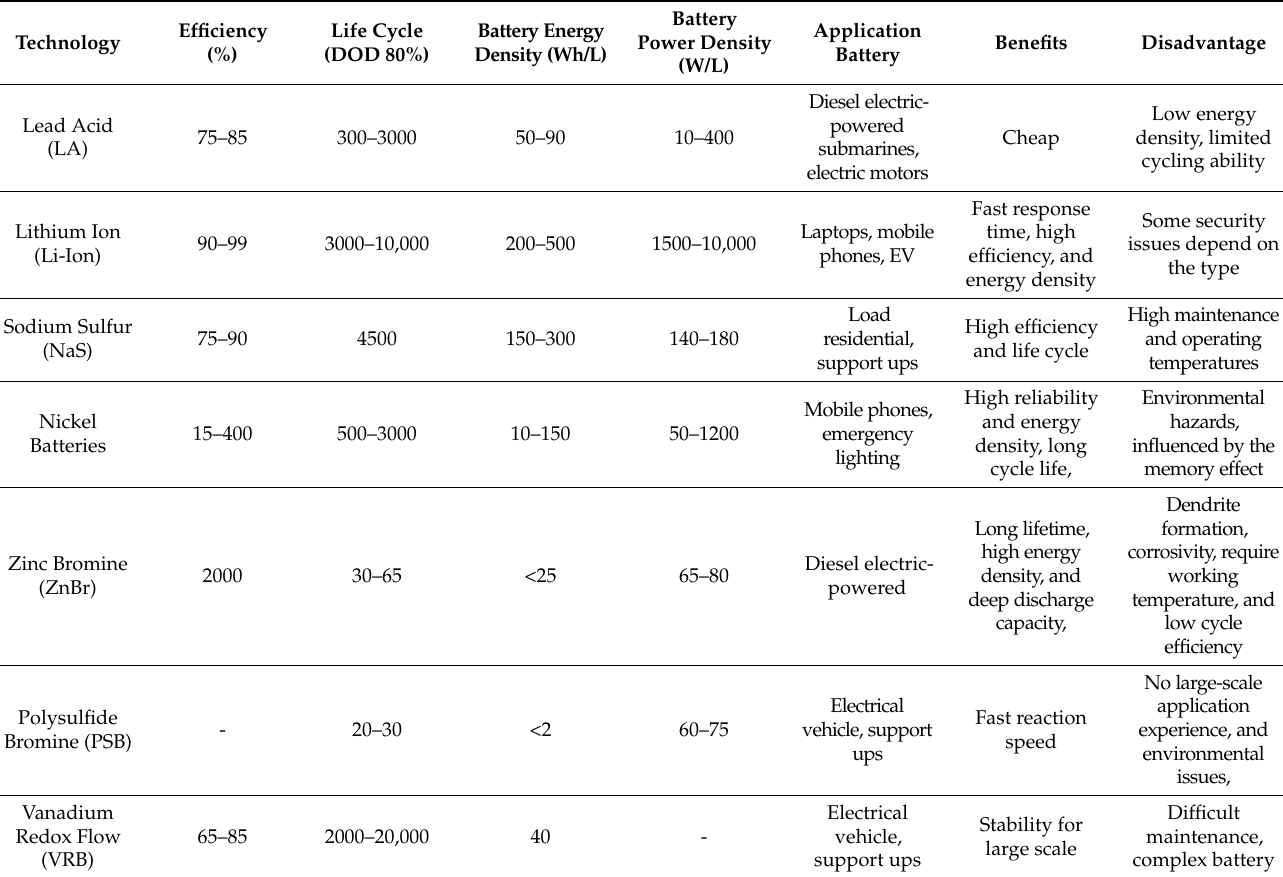
Table 6. Review of technology BESS [65–69].